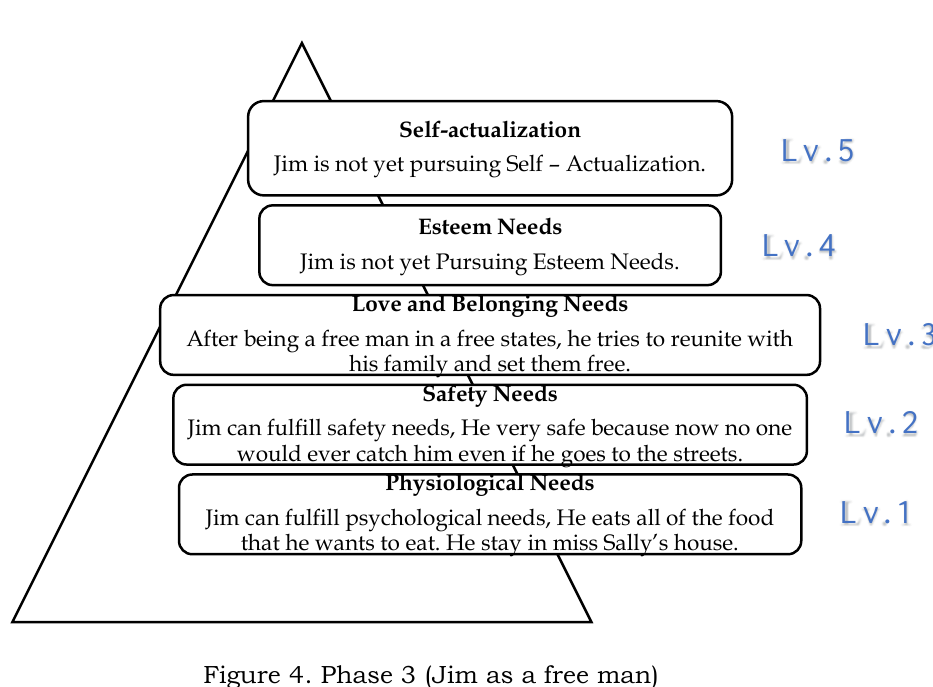
Figure 4. Phase 3 (Jim as a free